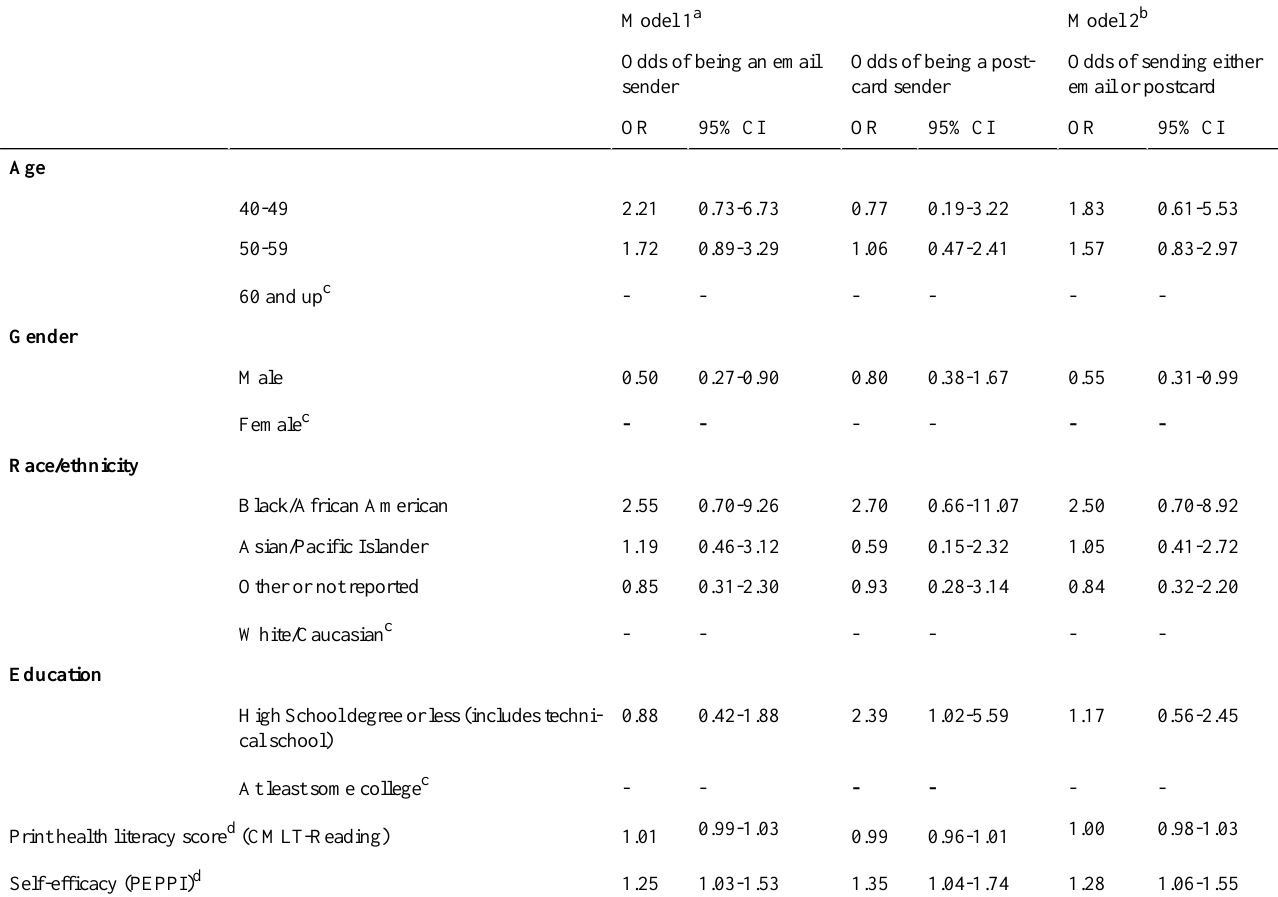
Table 5. Willingness to send messages sharing CRC screening experience with